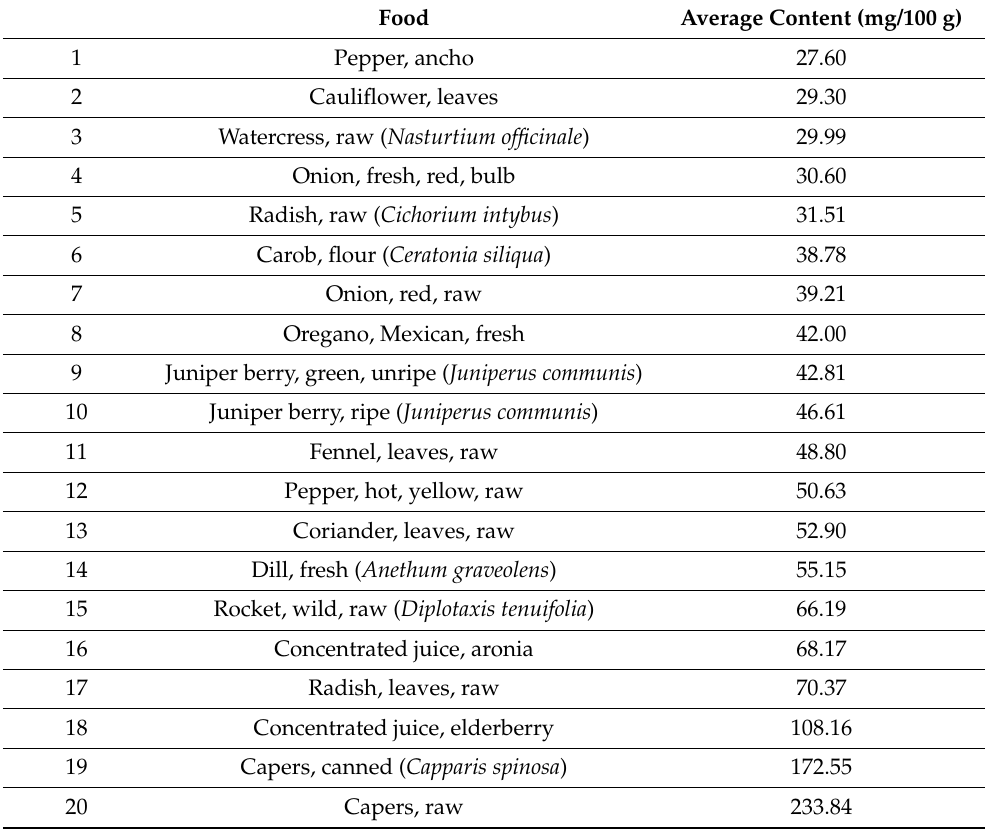
Table 3. Foods rich in quercetin based on the USDA Database of Flavonoids in Selected